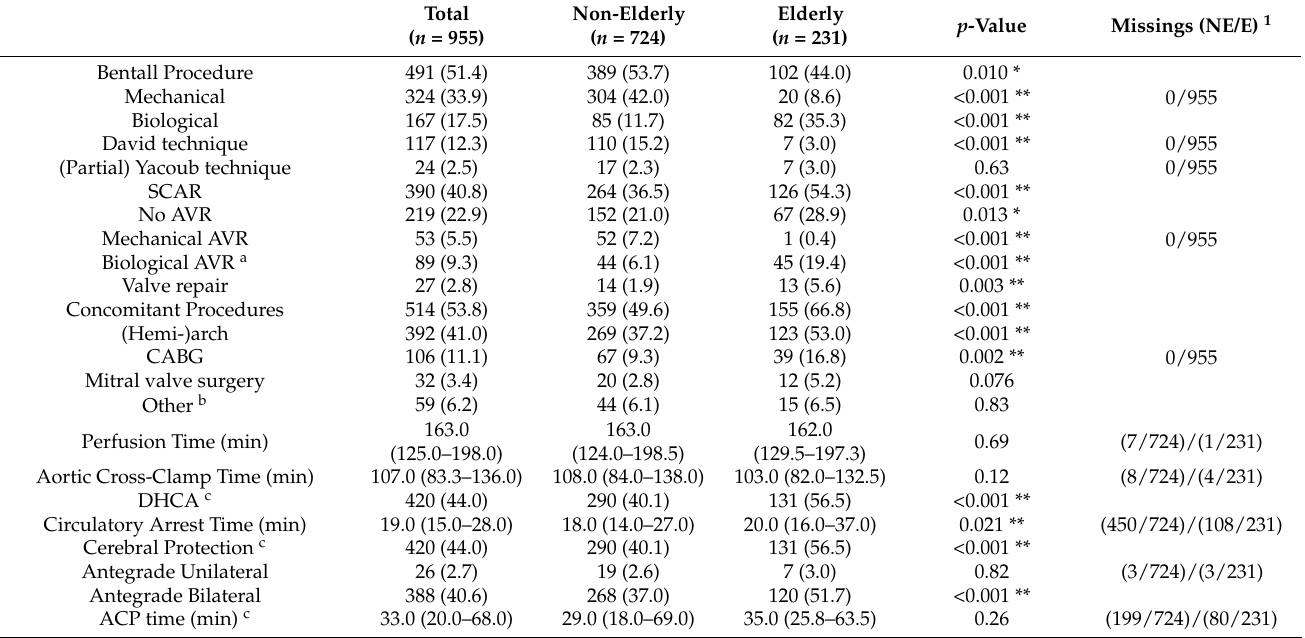
Table 2. Operative Characteristics.